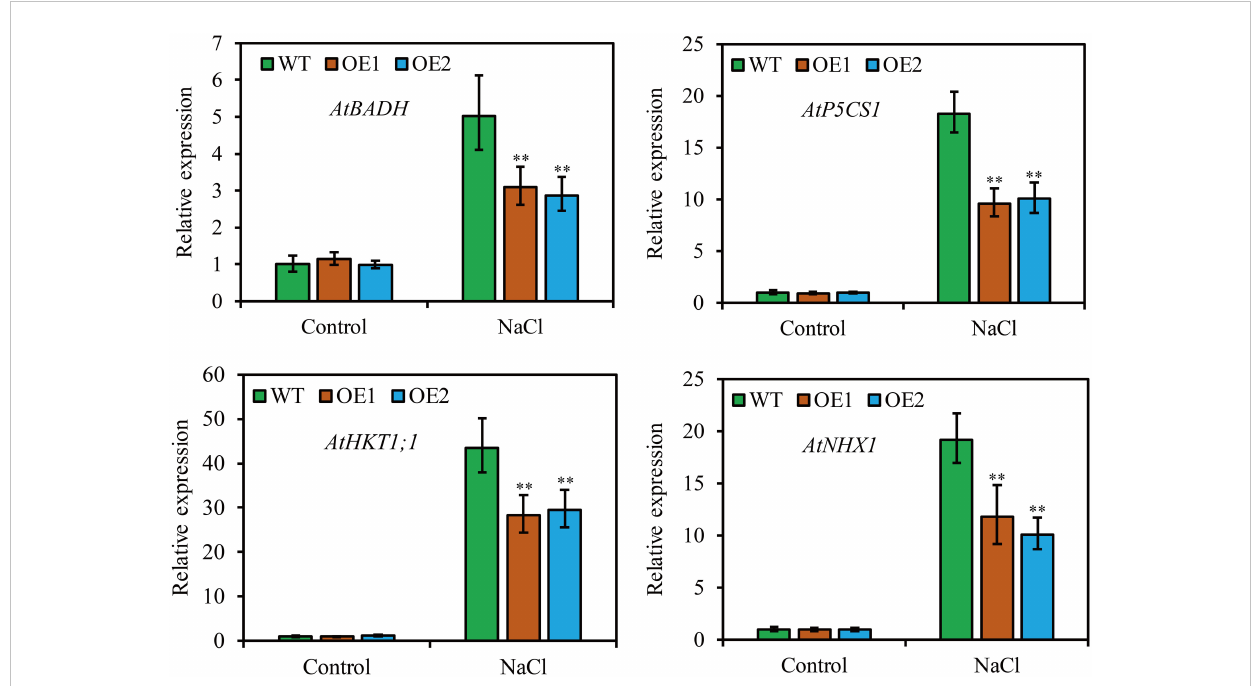
FIGURE 7 Expression levels of abiotic stress-related genes in wild-type and overexpressing plants under salt stress and non-stress conditions. Each experiment contains three biological replicates, and each with two technical replicates (means of n = 6 ± SD, asterisks above the bars indicate signi fi cant differences from wild-type controls at p <